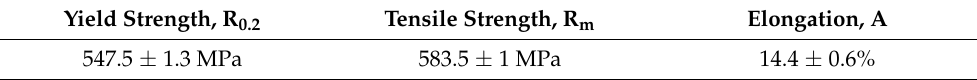
Table 2. Basic mechanical properties of AA7075-T651 alloy.